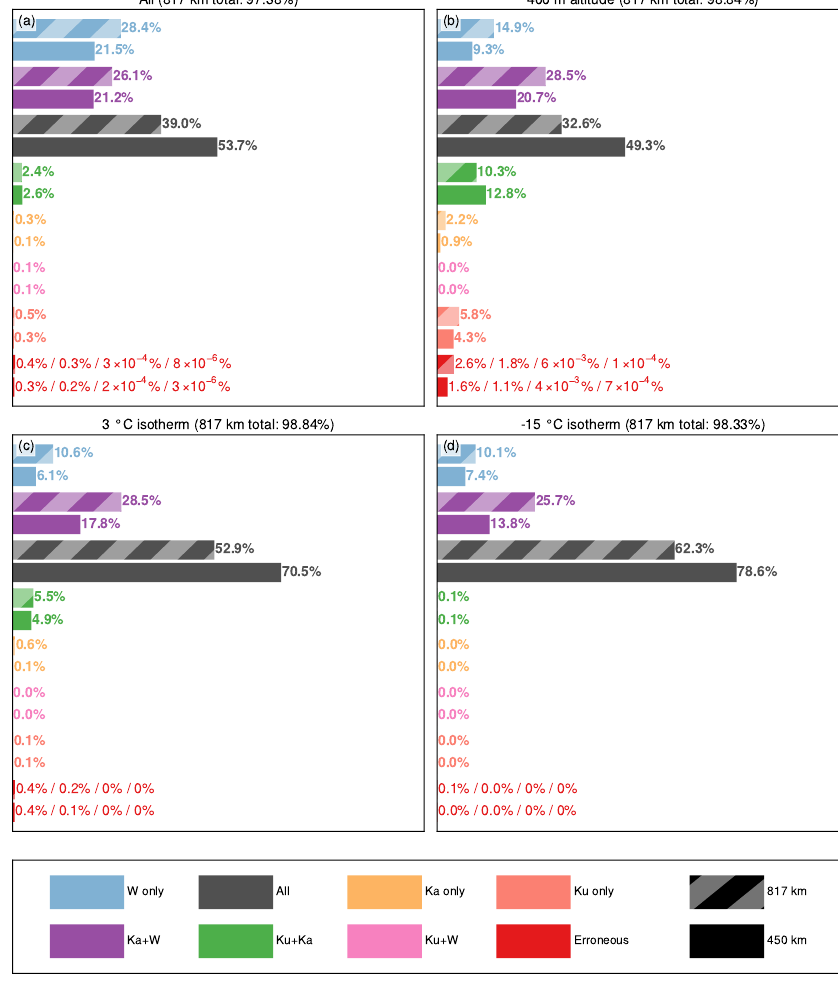
tudes, but not as strongly as with the oceanic case